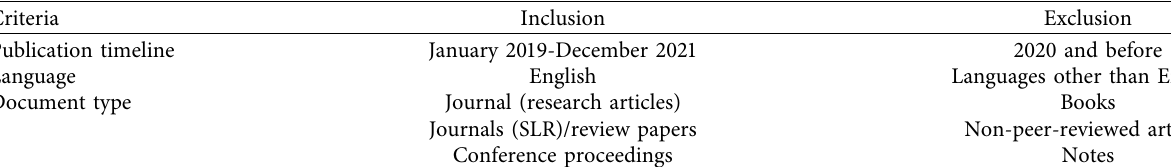
Table 1: Criteria for article inclusion and